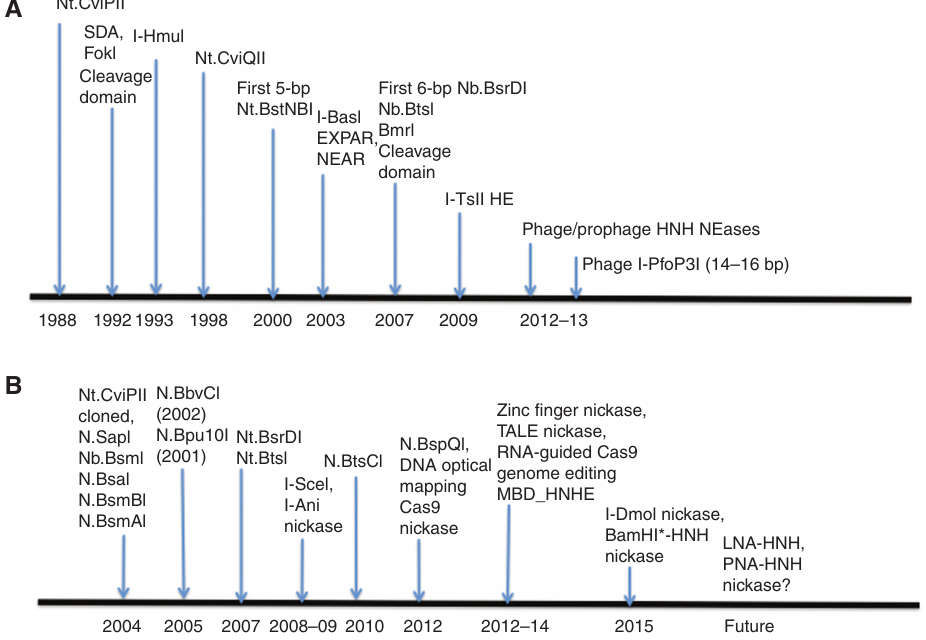
Figure 2: A timeline of nicking enzyme and nuclease cleavage domain (from type IIS REase) discovery (A), engineering (B), and two important NEase applications (EXPAR/NEAR, DNA optical mapping using nicking site profile). The timeline is not drawn to scale. The timeline is based on the year of publication or issued patent (not based on the time of manuscript submission or patent application). Other DNA nicking enzymes involved in DNA replication, repair, and plasmid transfer (conjugation) are not shown